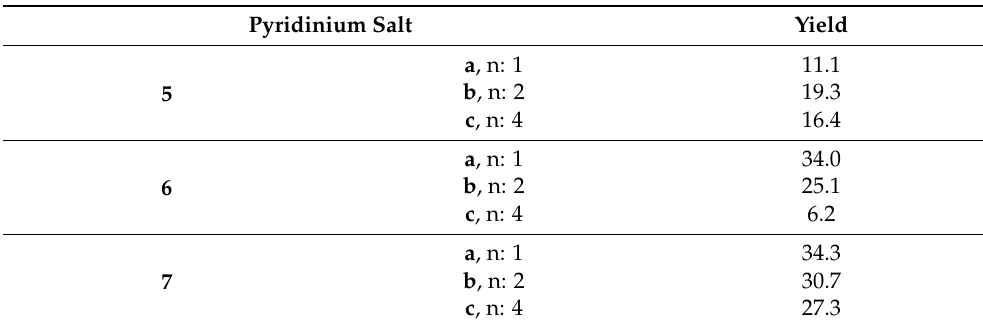
Table 2. Yields of curcuminoid-derived pyridinium salts 5a-c – 7a-c . Pyridinium Salt